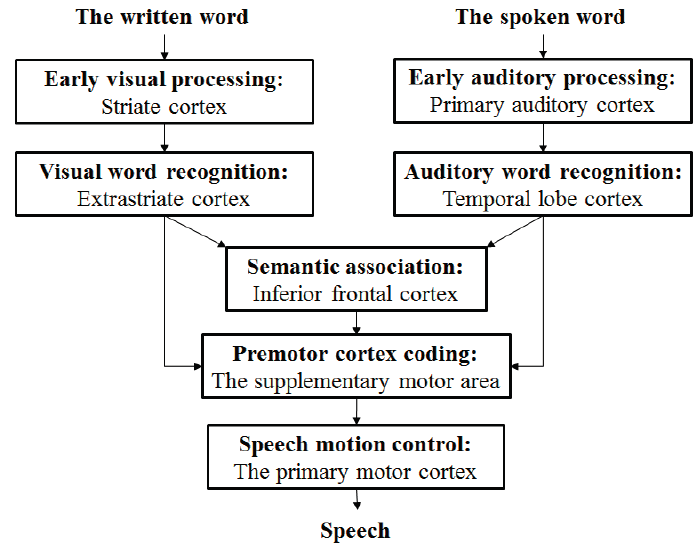
Figure 1. A language processing in neurolinguistics. This picture marks various